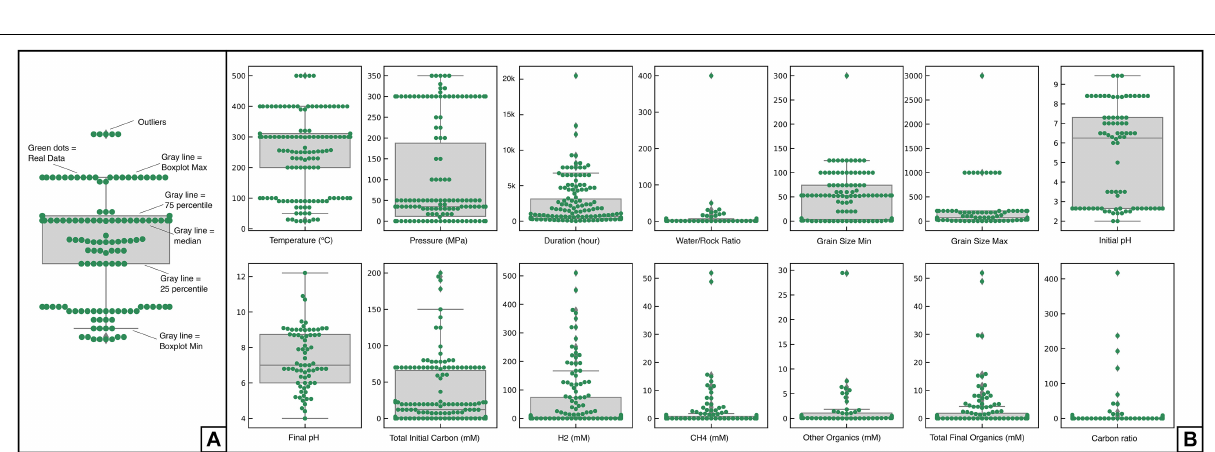
Frontiers in Earth Science |